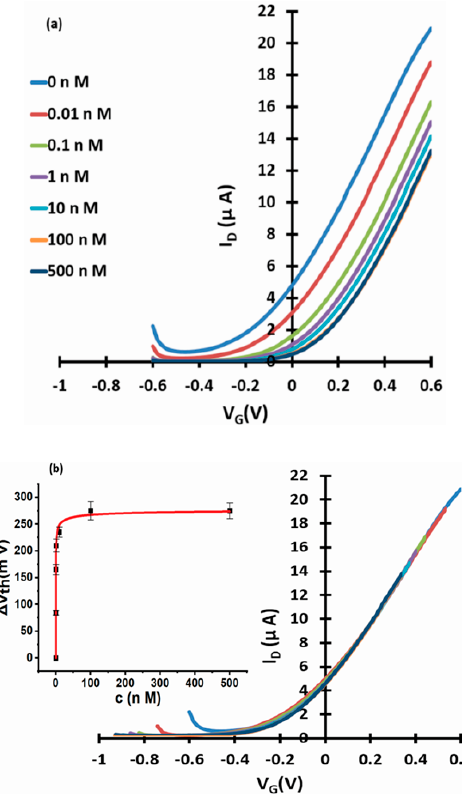
Figure 3. WGTFT fluoride (from NaF) response with La resin membrane. ( a ) Transfer characteristics of La-loaded chelating resin-sensitised SnO 2 WGTFT gated under increasing F − concentrations from NaF in the outer pool. ( b ) ‘Master’ transfer characteristic after shifting transfers from Figure 3a along the V G axis for optimal overlap. Inset to 3b: response characteristic with fit to Equation (3).